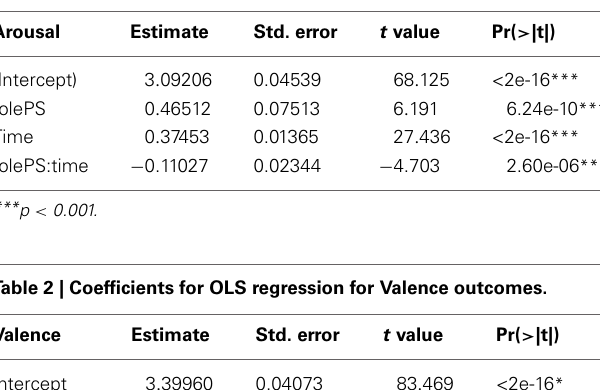
Table 1 | Coefficients for OLS regression for Arousal outcomes.